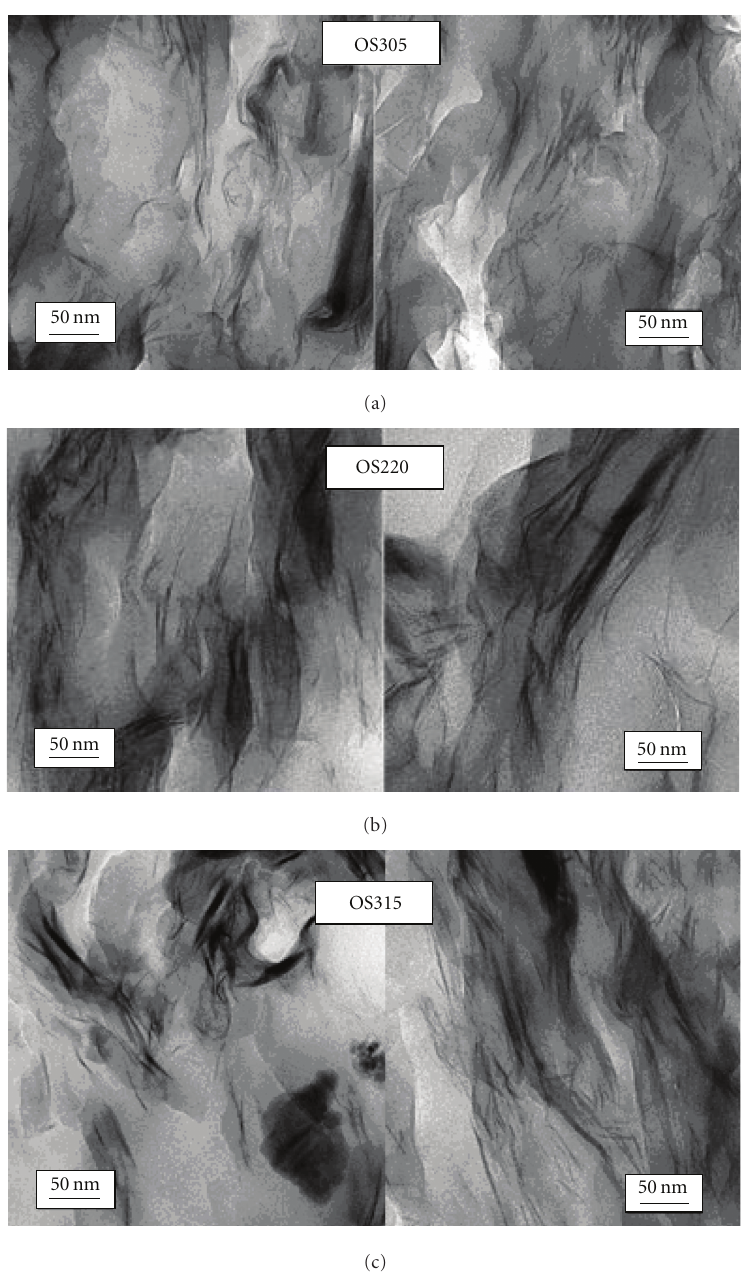
Figure 6: TEM image for representative samples, intercalation/exfoliation clearly